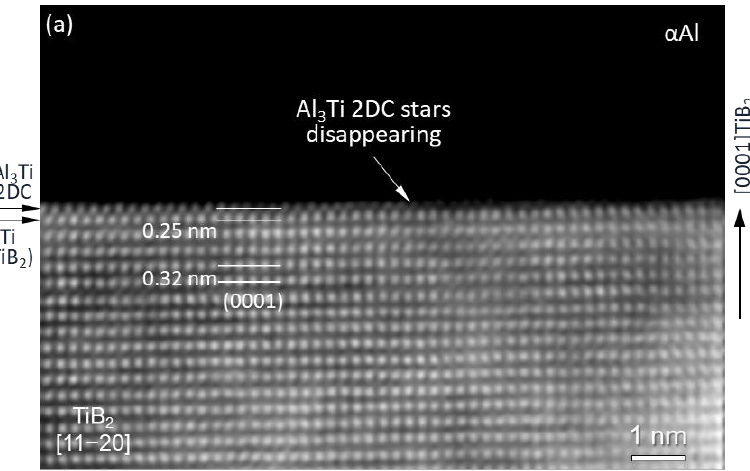
Figure 19. On-going of the dissolution process of Al 3 Ti 2DC at Al/TiB 2 interface [30]. High resolution STEM HAADF image of the Al/TiB 2 interface viewed along [1 1 2̅ 0] TiB 2 direction, showing the remaining Al 3 Ti 2DC layer on the left-hand side of the (0 0 0 1) surface of TiB 2 particle added to Al-2Si alloy melt.